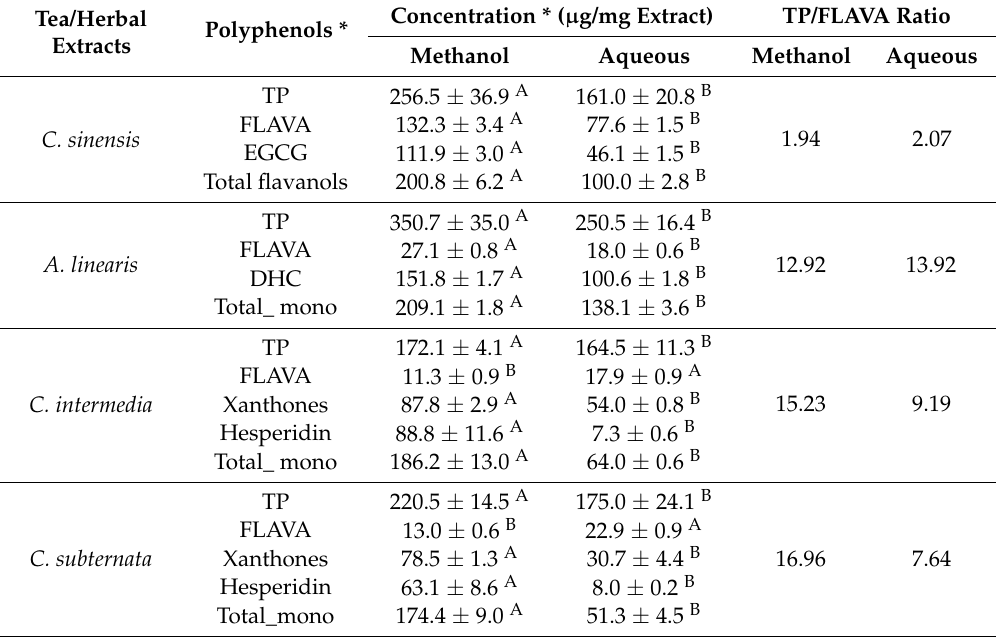
Table 5. Concentration of TP, FLAVA and monomeric polyphenolic compounds of the methanol and aqueous extracts of green tea and herbal teas expressed as the TP/FLAVA